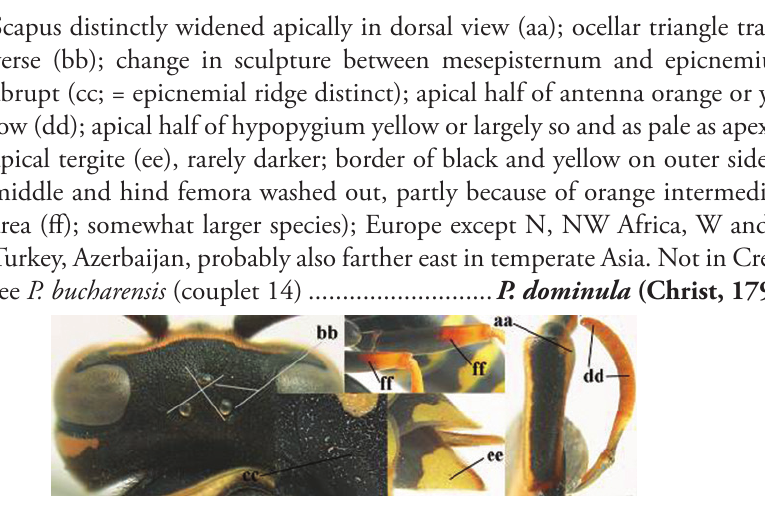
13 Apical half of sternite VI yellow or largely so, and as yellow as apex of last tergite (a); ventral part of mesopleuron in general more coarsely sculptured than remaining parts (b); [mesoscutum usually with two yellow spots; apical